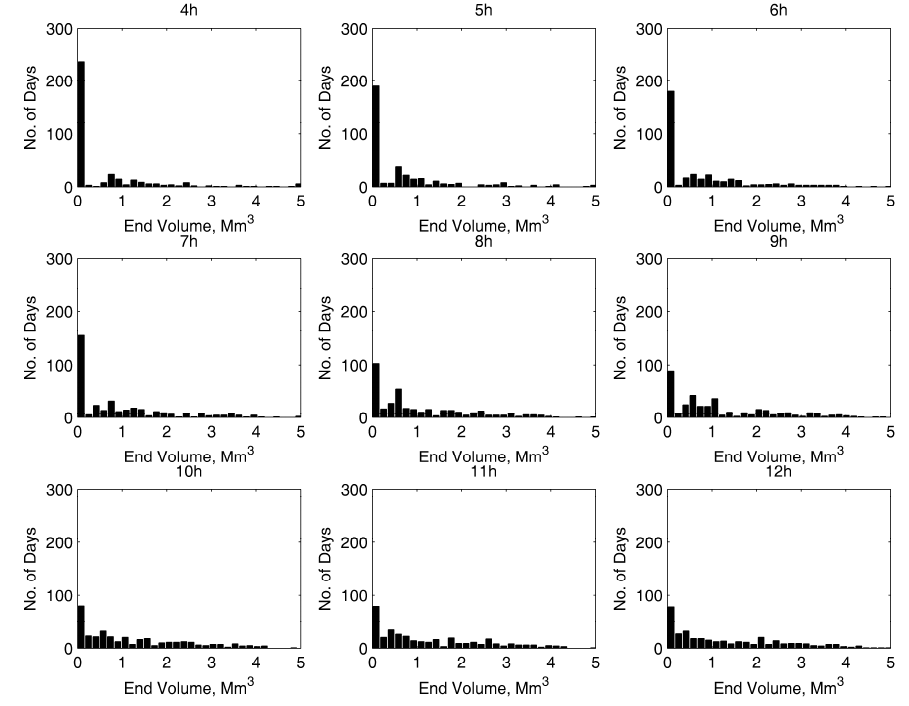
Figure 11. Histogram of the end of day volumes for each PSHP participating in the DM and SRS.